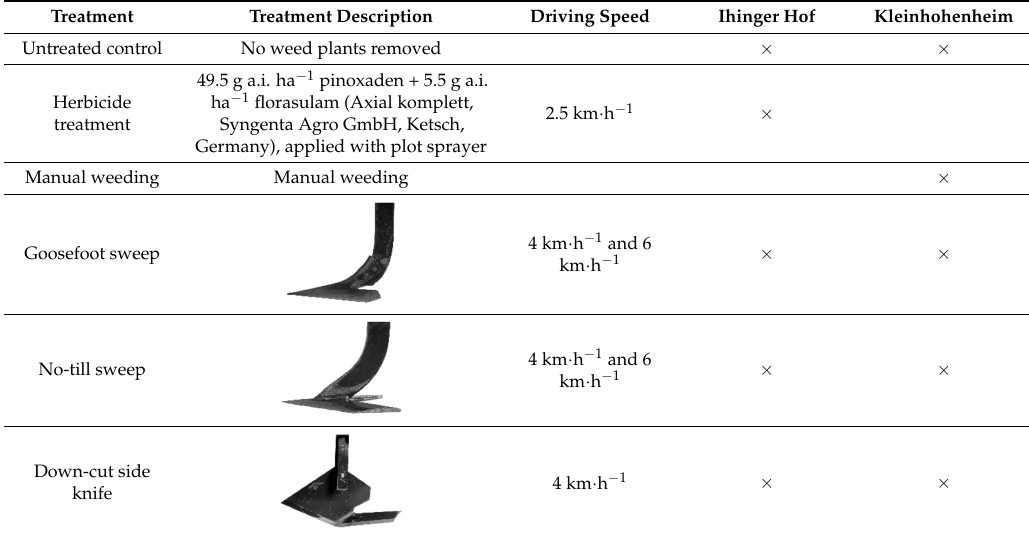
Table A1. Overview of the treatments at Ihinger Hof and Kleinhohenheim in